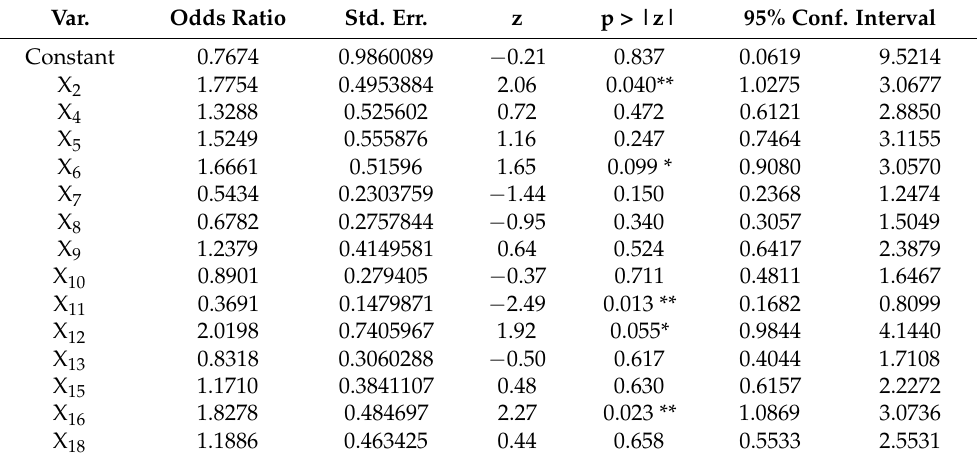
Table 4. Evaluation results for the logit model of innovation activity: odds ratios. Var. Odds Ratio Std. Err. 95% Conf.